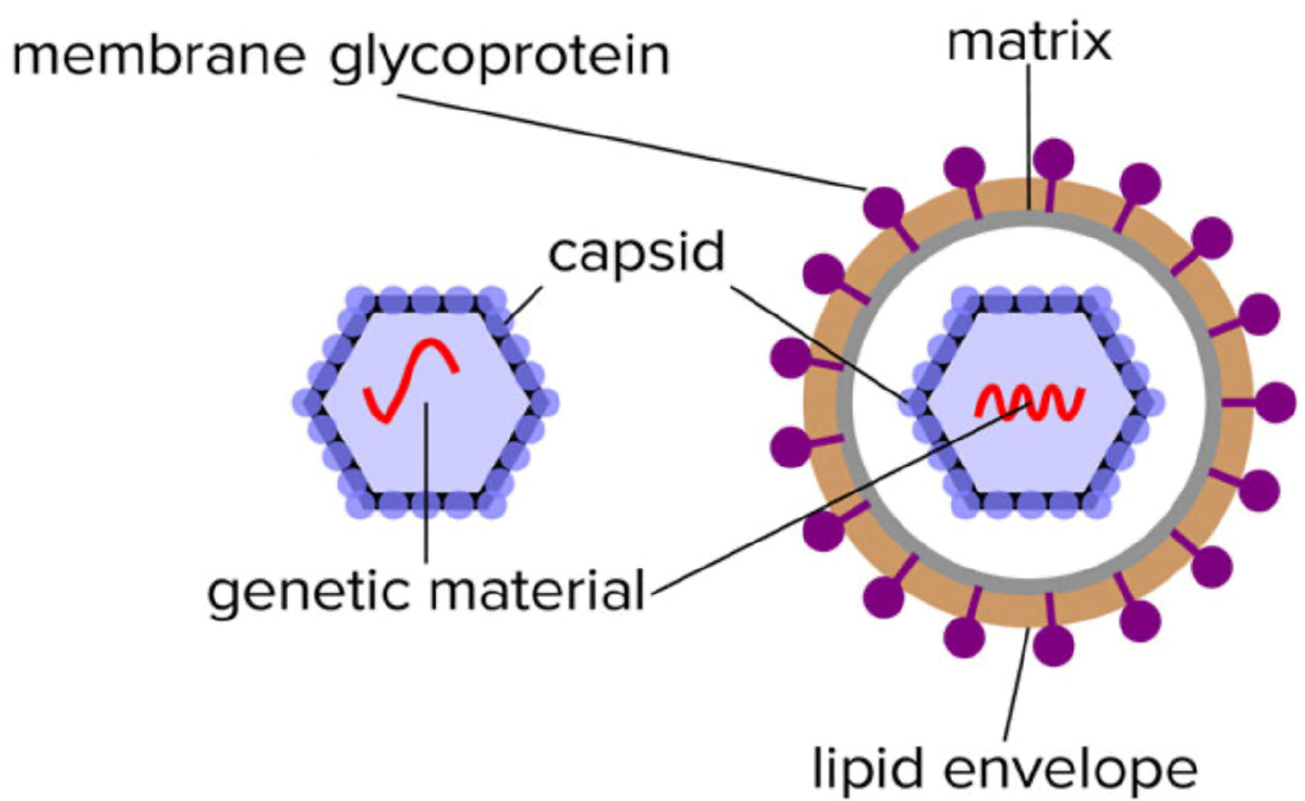
Figure 1. Illustration of the limited composition of unique proteins found in the isolated non- enveloped an enveloped virion particles.